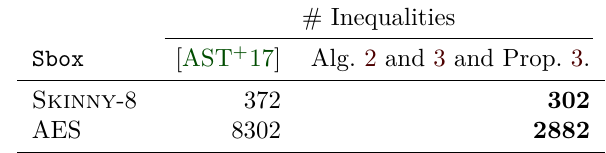
Table 4: Number of inequalities to model the corresponding Sboxes, where the set of initial inequalities was generated by three different methods: Alg. 2 and 3 and Prop. 3 # Inequalities Sbox [AST + 17] Alg. 2 and 3 and Prop. 3. Skinny -8 372 302 AES 8302